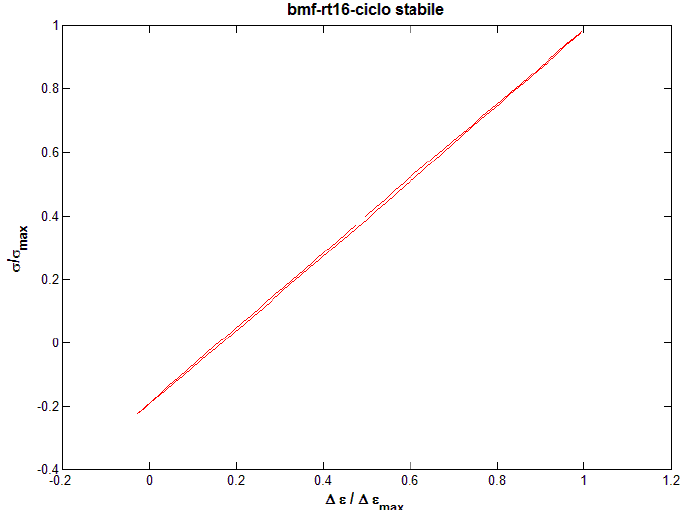
Figure 4: Example of stabilized hysteresis